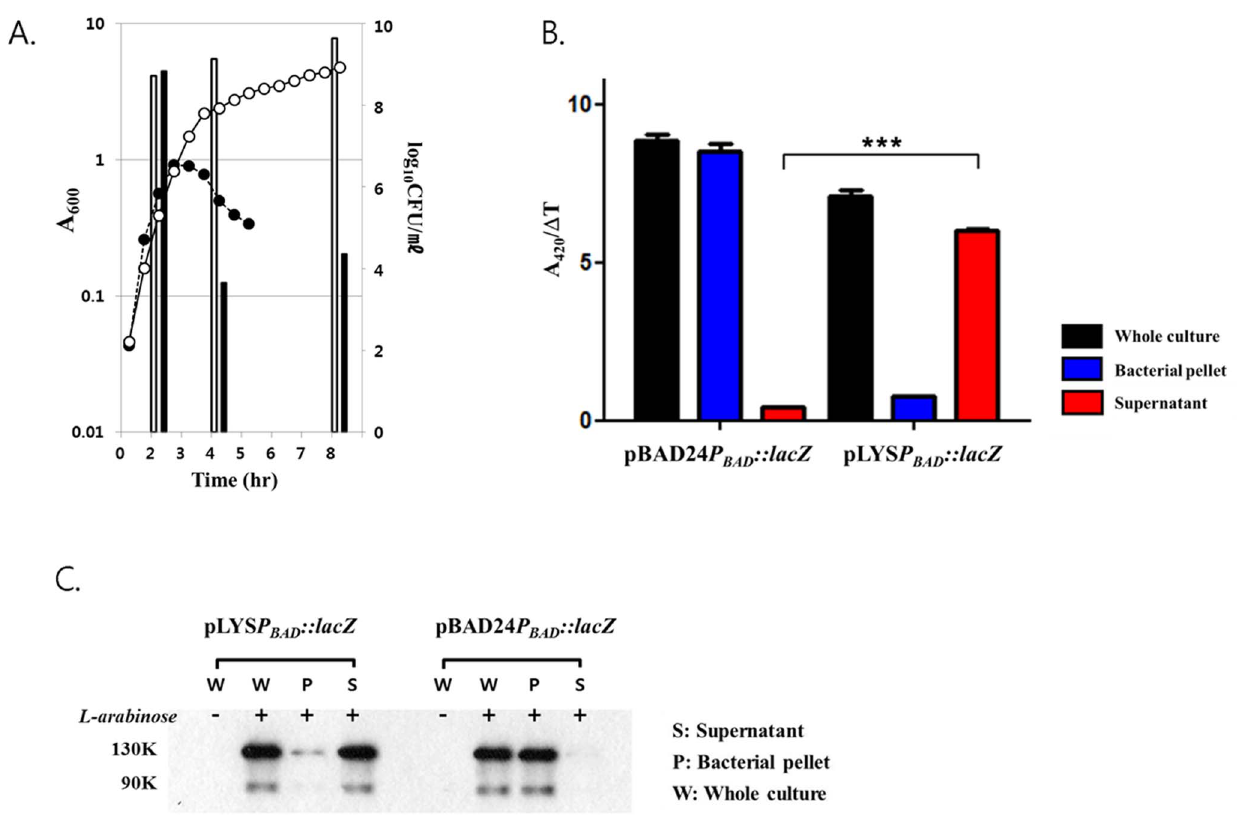
Figure 2. Bacterial lysis phenotype of pLYS. (A) S. typhimurium carrying pLYS were grown in LB supplemented with L-arabinose. When the optical density (A 600 ) of the culture reached , 1.0, at T=2 hrs, the LB was supplemented with L-arabinose in half of the cultures. The A 600 of the culture was measured at regular time intervals (circles) and viable bacteria were determined by CFU counting (bars). Open circles and bars represent bacteria samples without L-arabinose addition, and filled circles and bars represent bacterial samples with L-arabinose addition. (B) S. typhimurium carrying either pLYS P BAD ::lacZ or pBAD24 P BAD ::lacZ grown in LB was supplemented with L-arabinose when the A 600 of the culture reached , 1.0. The bacterial culture was taken 2 hrs after the addition of L-arabinose, separated into bacterial pellet and supernatant by centrifugation and filtration, and assayed for total b -galactosidase activity. Data represent mean 6 S.D., and asterisks (*) indicate a significant difference compared between supernatant of pLYS P BAD ::lacZ and pBAD24 P BAD ::lacZ (***, P , 0.0001). (C) The same samples were analyzed for b -galactosidase expression by Western blot analysis. 50 m g of sonicated samples were analyzed. Bacterial whole culture not induced for bacterial lysis was included.